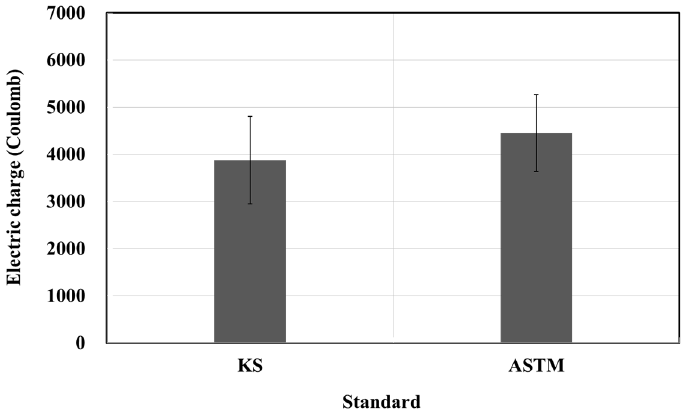
Figure 2. Resistance to chloride ion penetration electric charge test results based on the KS and ASTM standards.